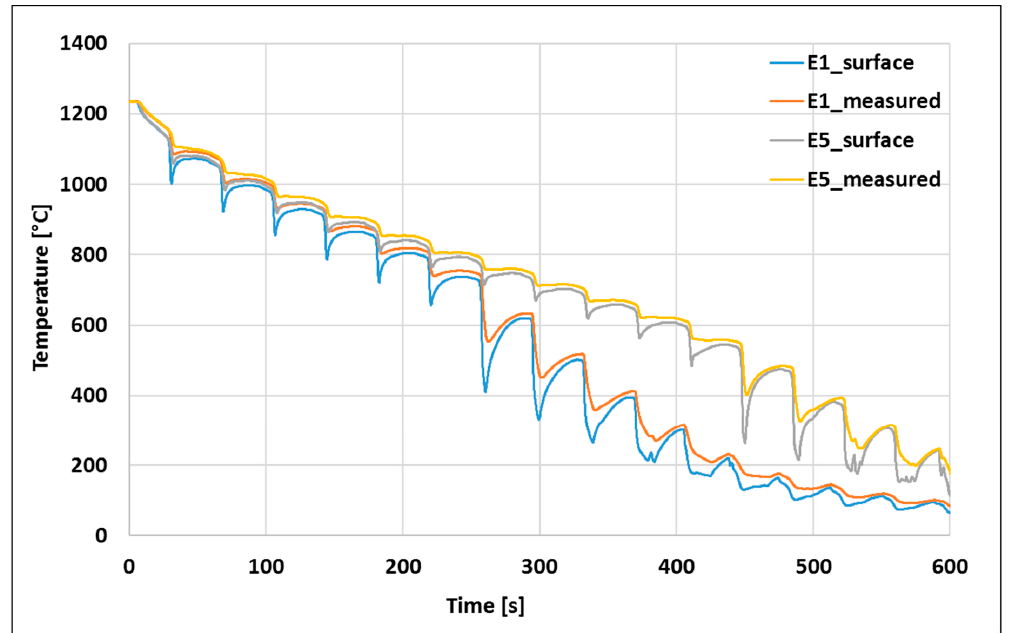
Figure 3. Temperatures measured at a depth of 2 mm and computed surface temperatures, data for experiments E1 and E5 in position of nozzle axis.